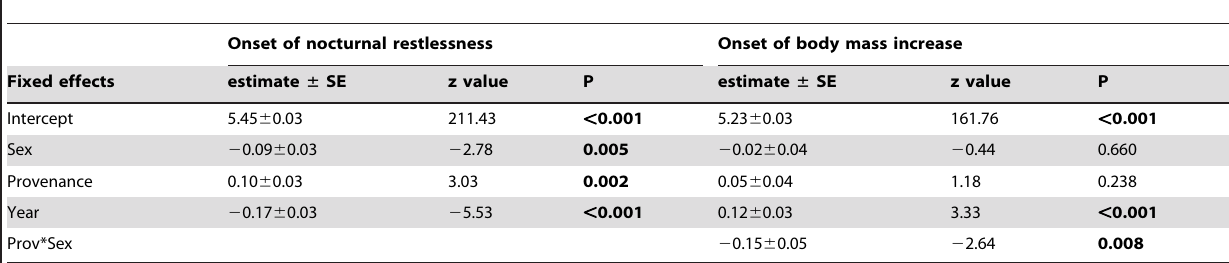
Table 1. GLMMs for effects of sex, year and provenance on onset of nocturnal restlessness and body mass increase in spring.